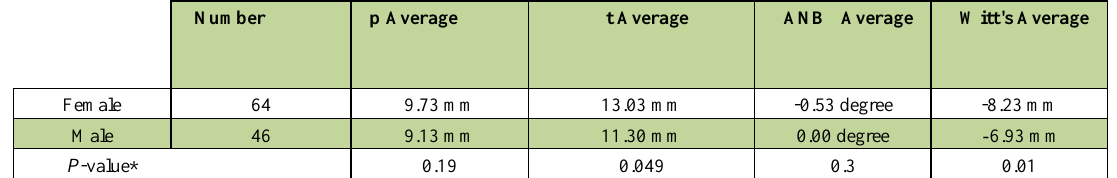
Table 1. Averages of p, t, ANB, and Witt's indices in females and males.